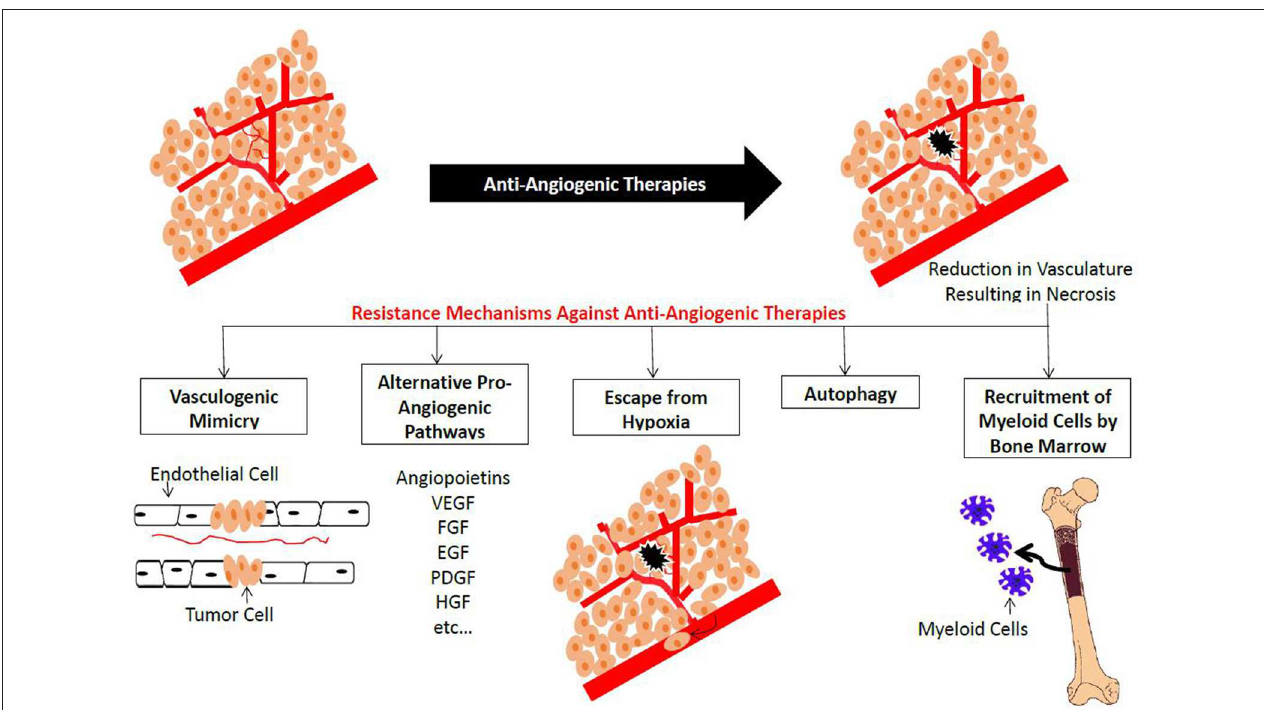
FIGURE 4 | Summary of plausible resistance mechanisms to Anti-angiogenic Agents. Treatment with anti-angiogenic agents results in a reduction in the blood vessel network. This new hypoxic condition results in the activation of vascular mimicry, altemative pro-angiogenic pathways, recruitment of bone man · ow-derived EC precursors and myeloid cells, as well as cell survival mechanisms such as